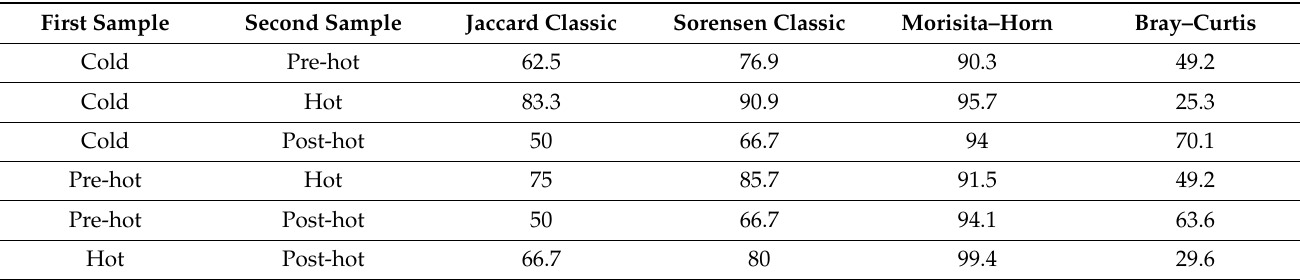
Table 4. Similarity analysis (in %) between number of scorpions and seasons in the region of Ghardaïa, Algeria.